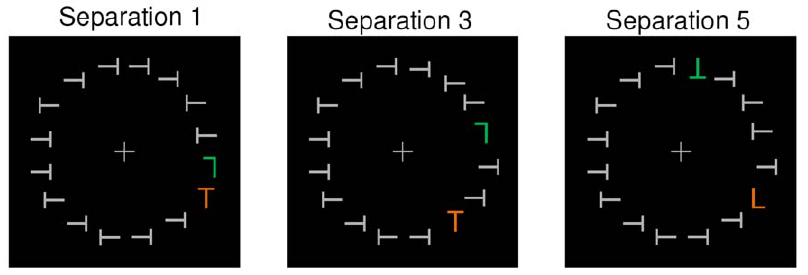
Figure 1. Examples of the stimulus displays used in Experiment 1. The two colored items (orange and green) were the targets and participants judged whether they were the same or different letters. The examples show displays where participants would respond ‘‘different.’’ Target-target separation was varied in three levels: Separation 1, Separation 3, and Separation 5.